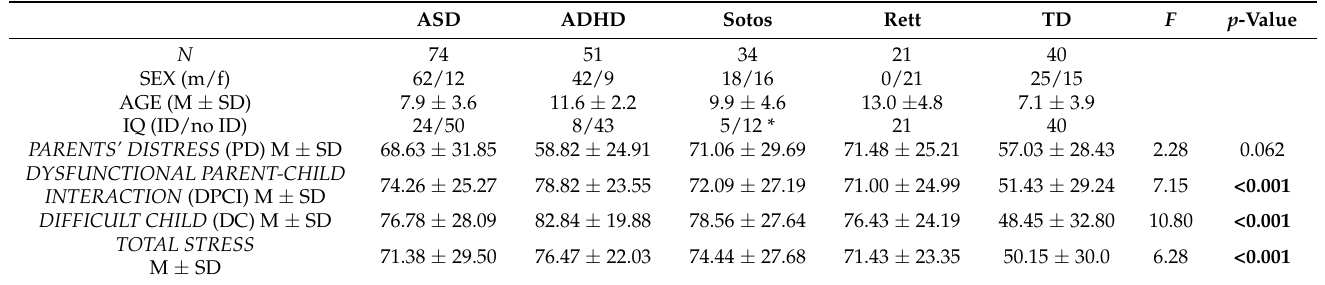
Table 1. Demographic characteristics of the sample and main